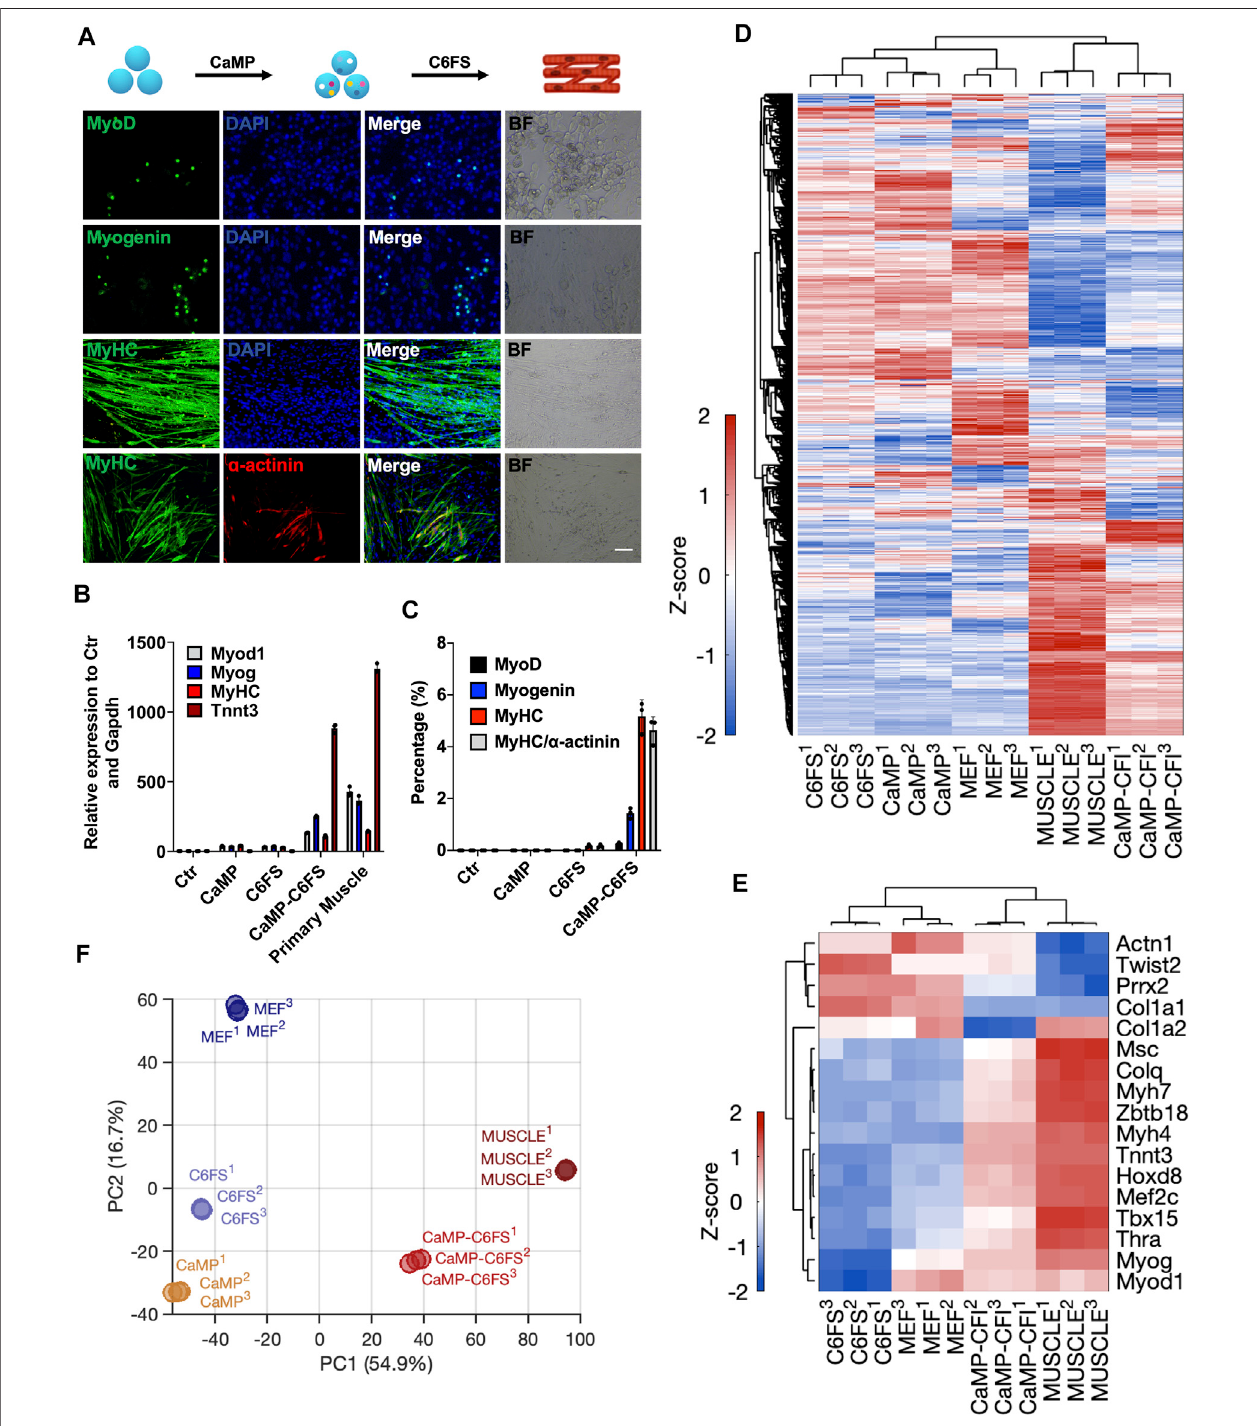
FIGURE 6 | Direct chemical reprogramming system into myocytes was empowered with CaMP induction. (A) Induction of skeletal muscle cells with the CaMP pretreatment.Scalebar,100 μ m;C6FS,CHIR99021/616452/Forskolin/SB431542. (B) RelativemRNAexpressionoftypicalskeletalmusclemarkergenesinducedwith orwithoutCaMPpretreatment. (C) Theef fi ciencystatisticsofinducedskeletalmusclecellsidenti fi edbyimmunostaining. (D) Geneexpressionheatmapofalldifferentially expressed genes (normalized FPKM changed more than 1.5 among the samples) in skeletal muscle cells induced with or without CaMP step (analyzed by RNA- Seq of more than 30 clusters of induced skeletal muscle cells). The color key, Z-score of normalized FPKM. (E) Gene expression heatmap of typical skeletal muscle genes in skeletal muscle cells induced with or without CaMP step (analyzed by RNA-Seq of more than 30 clusters of induced skeletal muscle cells). The color key, Z-score of normalized FPKM. (F) PCA projection of myocytes reprogramming processes analyzed with all differently expressed genes. The coef fi cient of variation (CV) was calculated for each gene among samples, and the PCA was performed with genes with CV larger than 0.1.